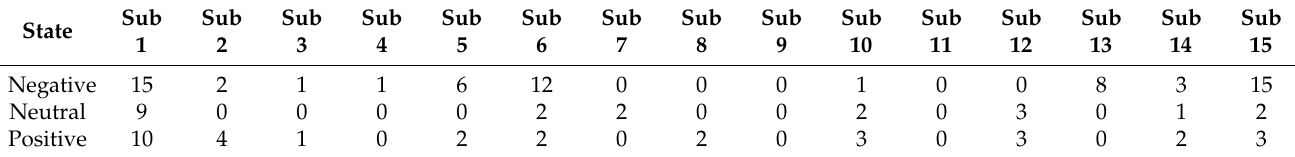
Figure 2. Three-dimensional visualization of faulty trials with overshooting/corrupted channels ( a ) subject: 1, state: negative, trial: 3 ( b ) subject: 1, state: neutral, trial: 4 ( c ) subject: 1, state: positive, trial: 15. Table 1. Distribution of trials with overshooting corrupt channels. Table 1. Distribution of trials with overshooting corrupt channels.